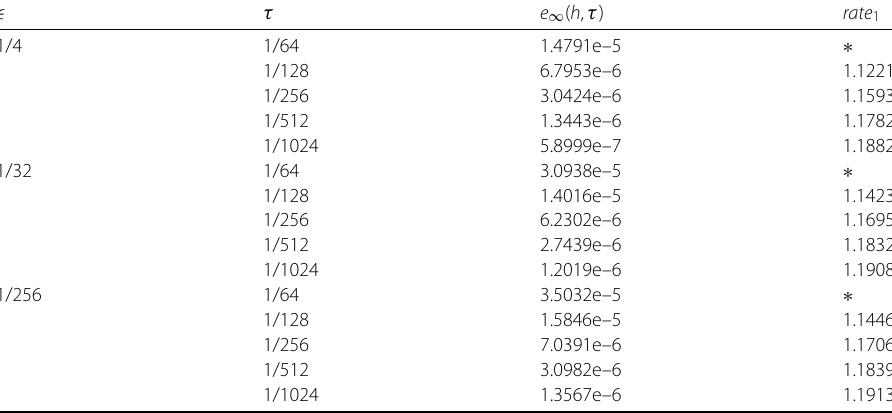
Table 2 The maximum absolute errors and temporal convergence orders with α = 0.8 and N =